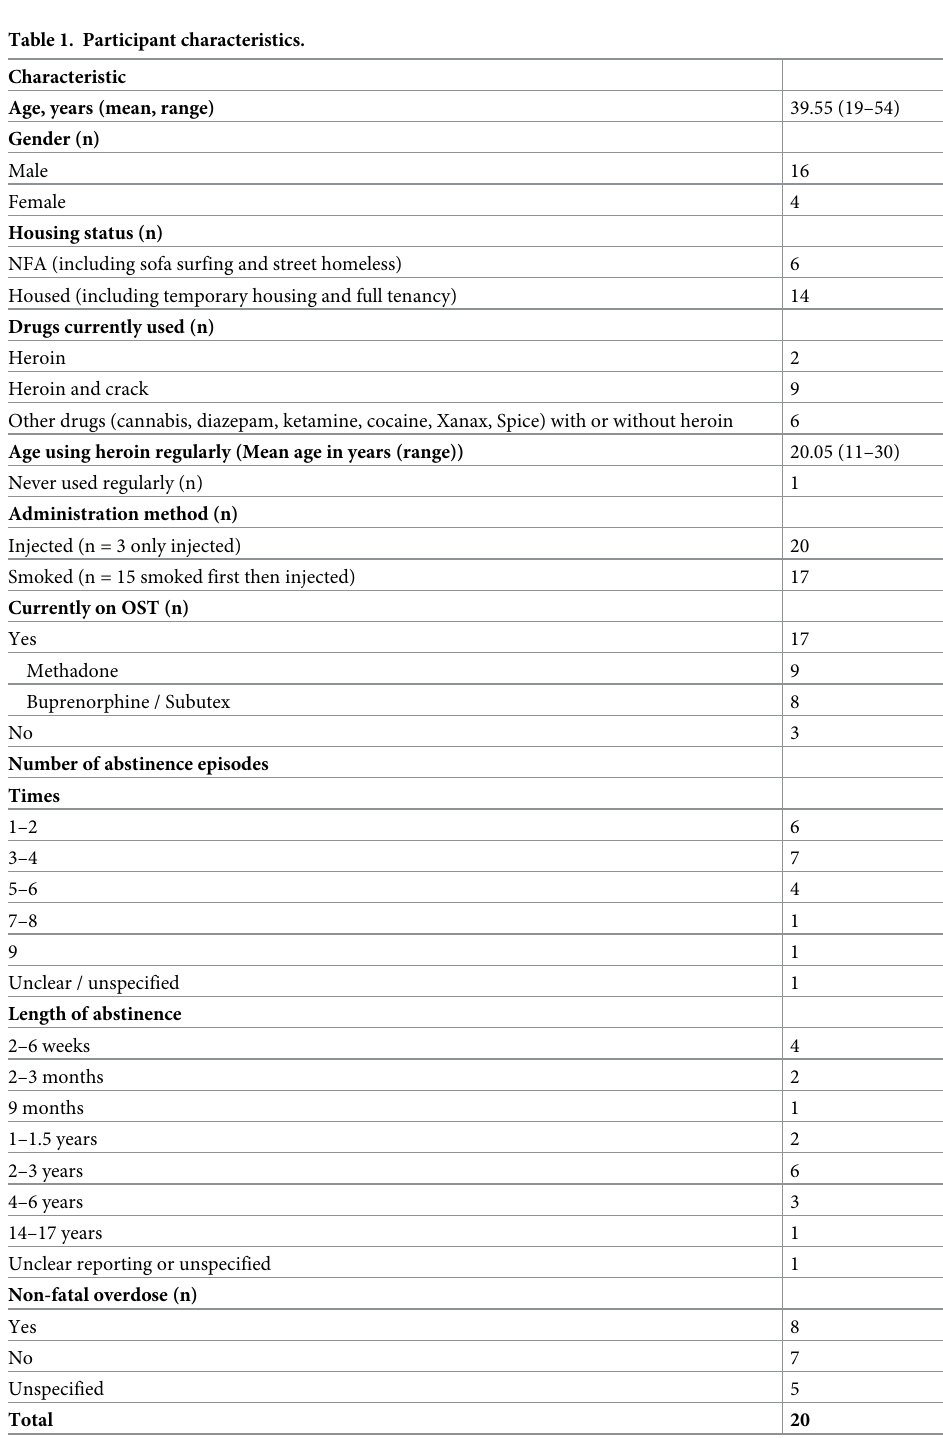
Table 1. Participant